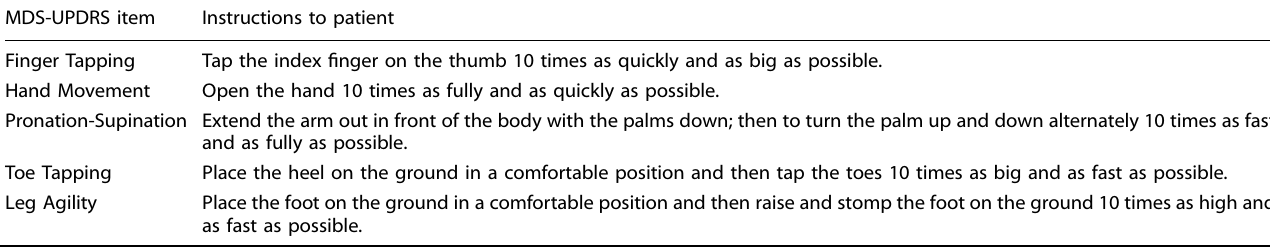
Table 5. Instructions given to patients for each of the fi ve main bradykinesia items in the MDS-UPDRS 3 . MDS-UPDRS item Instructions to patient Finger Tapping Tap the index fi nger on the thumb 10 times as quickly and as big as possible. Hand Movement Open the hand 10 times as fully and as quickly as possible.